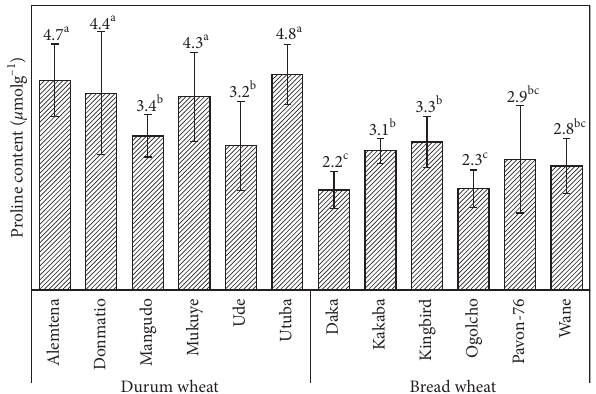
Figure 5: Means for the main effects of variety and water stress on the proline content of durum and bread wheat in Kulumsa.